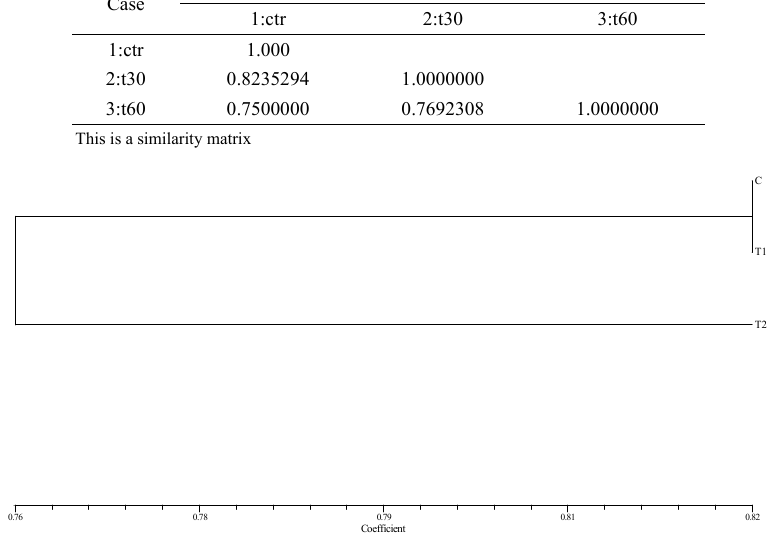
Fig. 6: Dendrogram obtained from analysis based on a rapid test using the UPGEMA method by NTSYS-PC